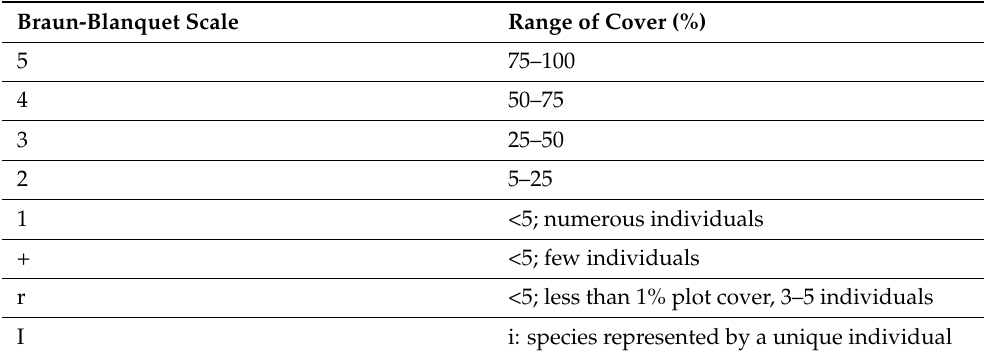
Table 4. Braun-Blanquet cover scale distribution that is used to estimate species importance in relation to other species within the same area or vegetation community. A scale of 5 is very important in terms of total area composition in relation to a species that falls in the scale of I, despite all being